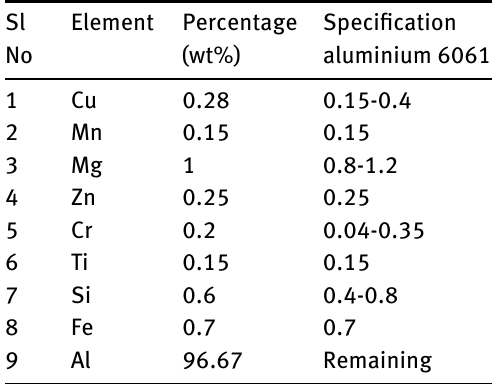
Table 1: Result of chemical analysis increasing percentage alloying element in aluminium 6061.